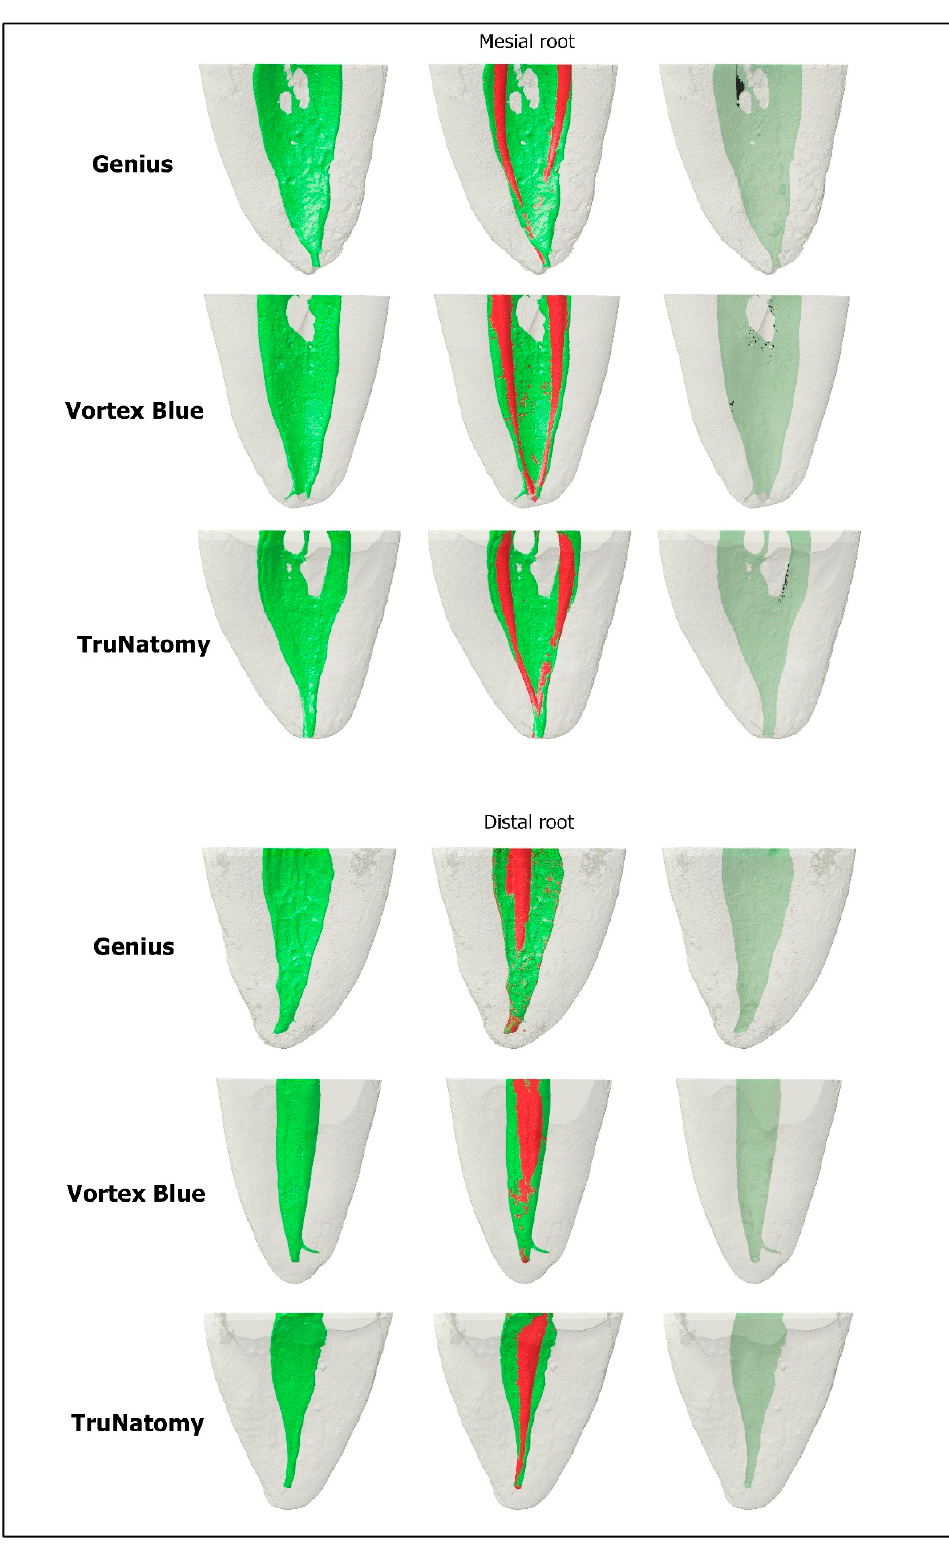
Figure 3. Representative micro-CT 3D models of mesial and distal canals of mandibular molars showing the root canals before (green color) (left column) and after (red color) preparation (central column) using the Genius Proflex, TruNatomy, and Vortex Blue systems. None of the shaping protocols were able to prepare the entire surface area of the root canal walls. Accumulated hard-tissue debris is depicted in black (right column).